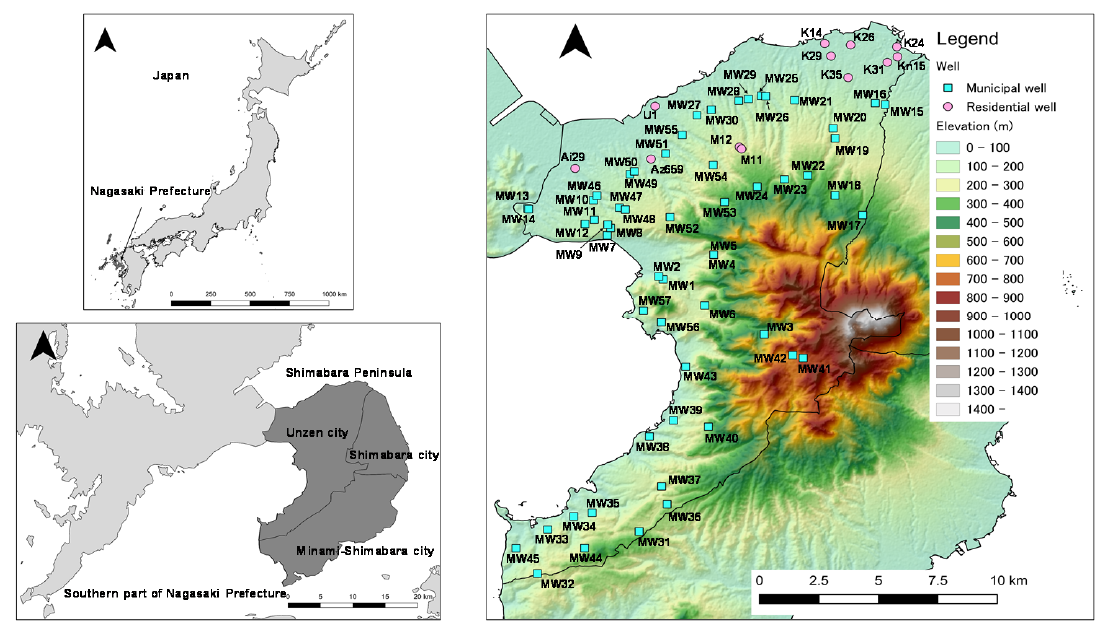
Figure 1. Study area and sampling locations.